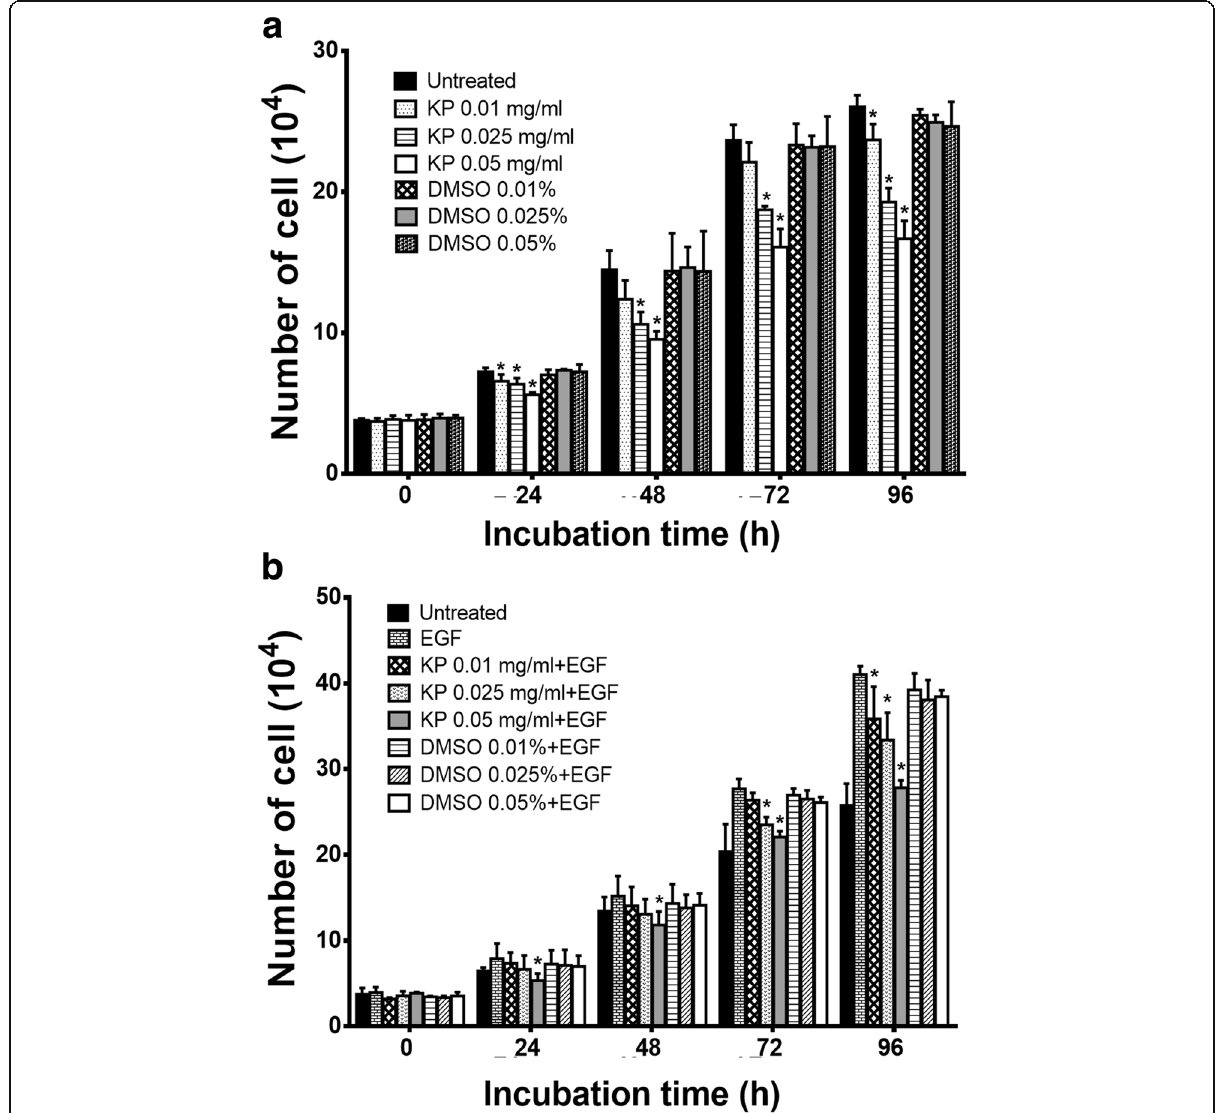
Fig. 2 The number of SKOV3 cells treated with non-toxic concentrations of KP (0.01, 0.025, 0.05 mg/mL) without EGF ( a ) and with 100 ng/mL EGF ( b ) at 24, 48, 72 and 96 h. Data are expressed as mean ± SD ( n = 3). * P < 0.05 as compared to untreated ( a ) or EGF ( b